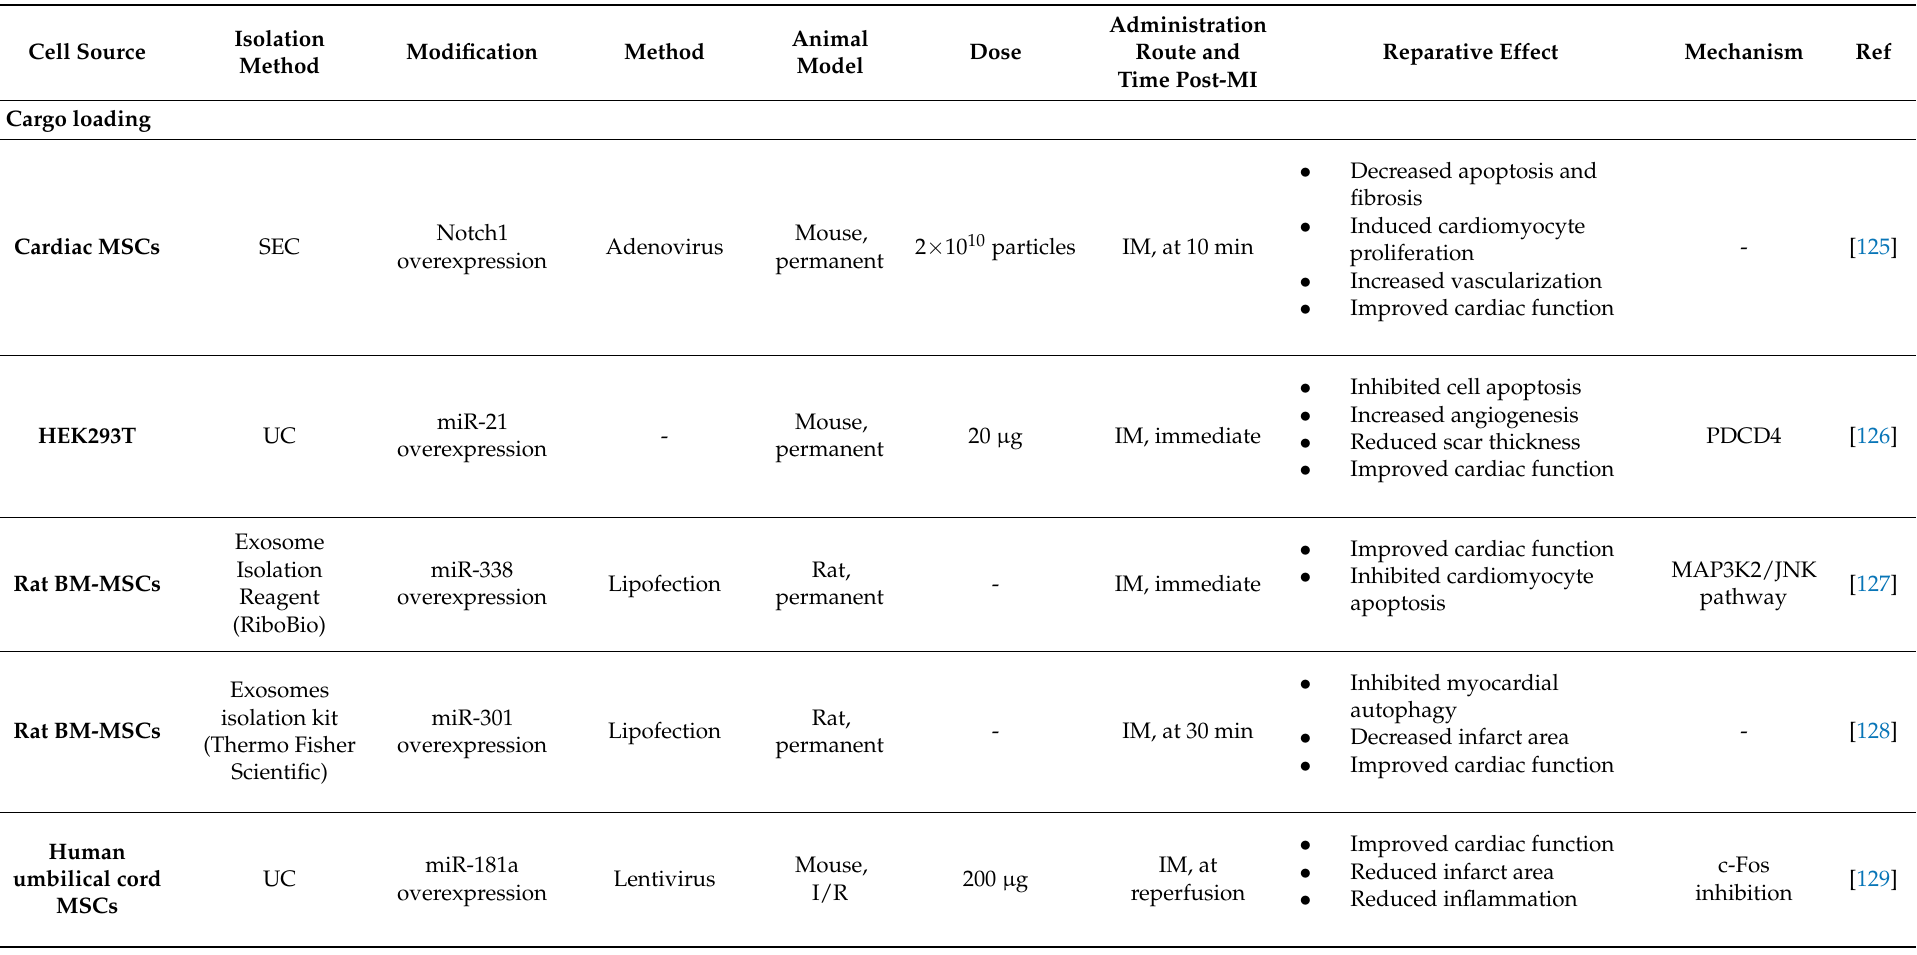
Table 3. Representative preclinical efficacy studies from the last five years using bioengineered extracellular vesicles as a novel class of drug delivery systems for myocardial